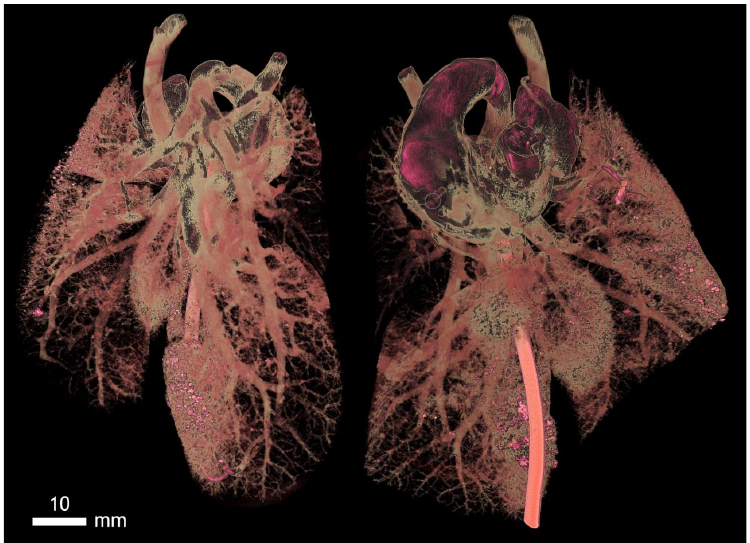
Figure A17. Rabbit lung vessels visualized by Mercox contrast, a corrosive preparation. Here, the passage of blood vessels in post mortem is ensured by intravenous application of resin by continuous pressure. It is possible to modify vascular ligatures in experiments and, thus, display a failure that is similar to embolism. It is also possible to subsequently measure the angle of the segmental vessels distances and their diameters. Appl. Sci. 2022 , 12 , x FOR PEER REVIEW